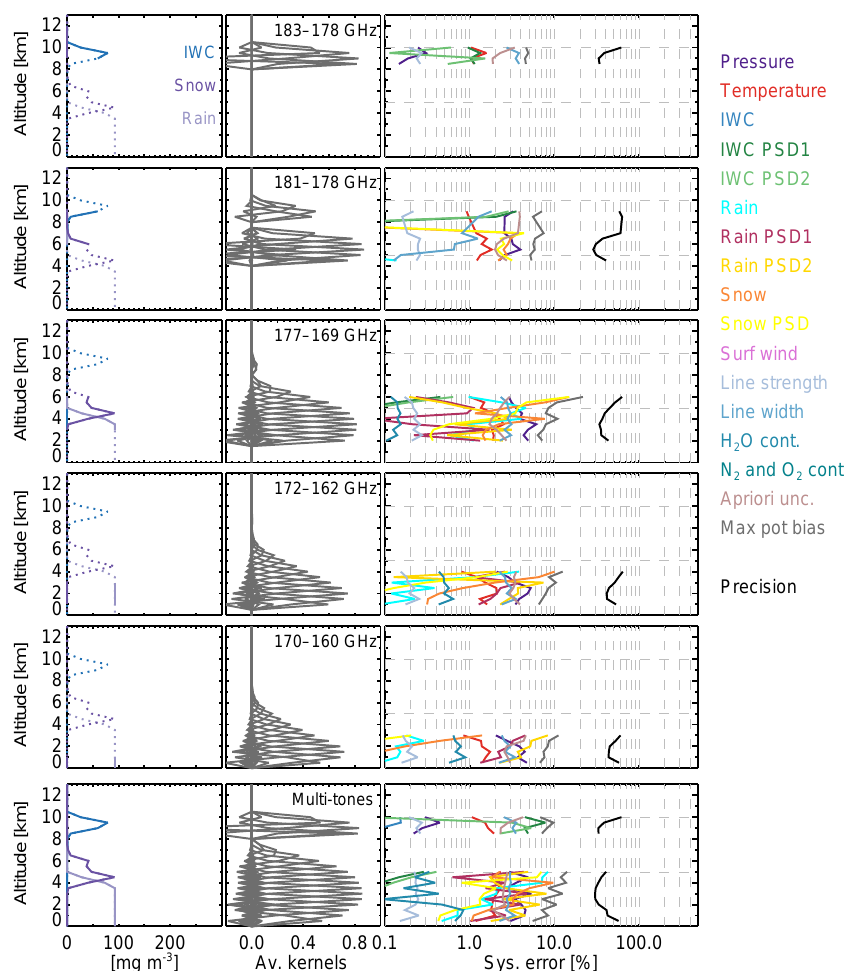
Figure 7. Left: color-coded hydrometeor burden. Dotted lines show the entire profile, while solid lines display the vertical range for which the radar tones used are better suited. Middle: averaging kernels. Right: systematic error estimates caused by each of the sources described in Table 2 as well as the precision and maximum potential bias. These errors are only shown for altitudes with kernels greater than 0.4, which indicates retrievals not influenced by the a priori. The top five rows show “optimized” radar tones for different vertical regions. The last row displays an example of how multi-tone (183, 177, 170, and 160GHz frequencies) retrievals can be used to sample an ample altitude range. Note that these multi-tone frequencies are not